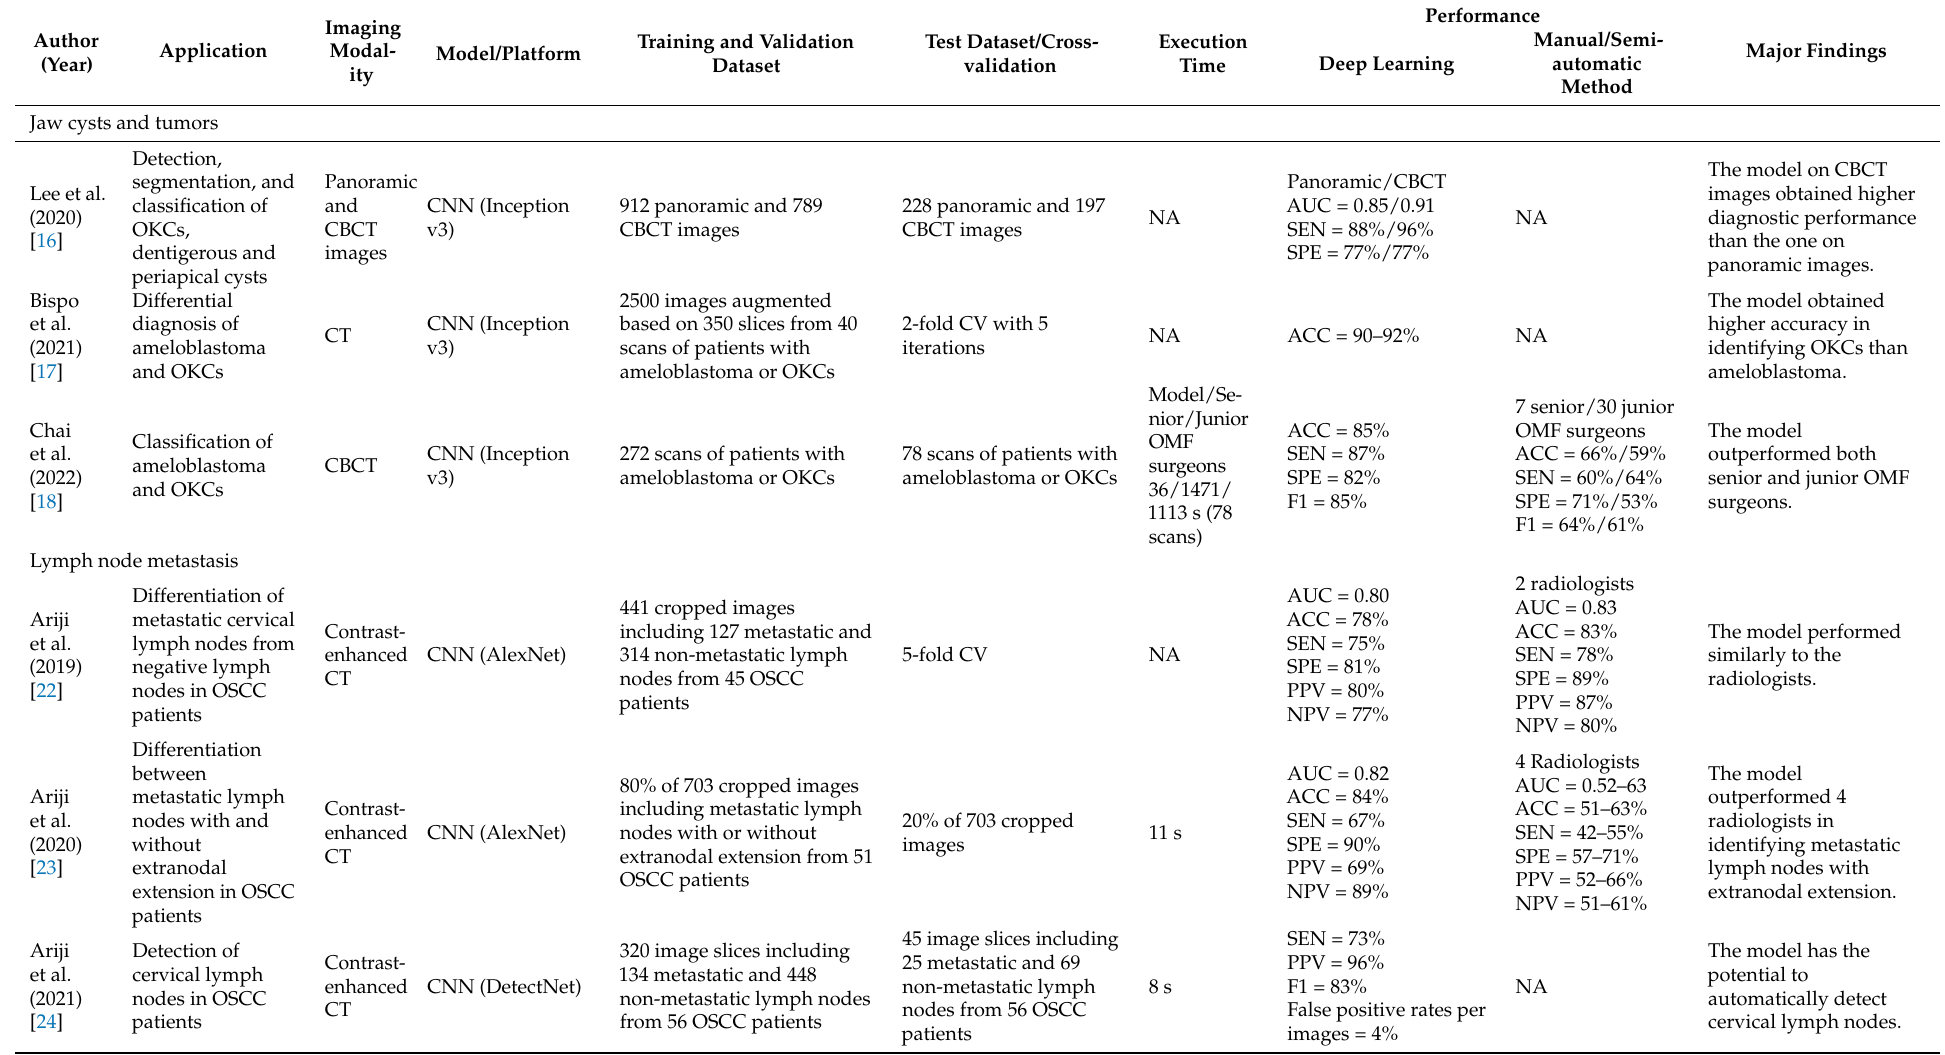
Table 1. Performance of deep learning models on CT/CBCT images for the diagnosis and treatment planning of maxillofacial